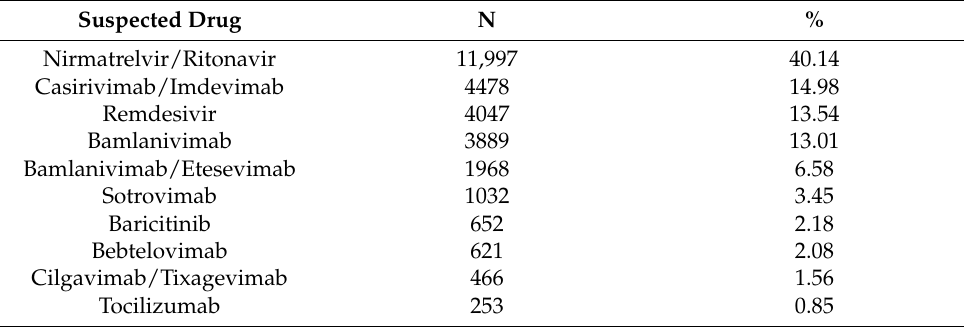
Table 1. Top 10 COVID-19 drugs reported as suspected drugs in FAERS.